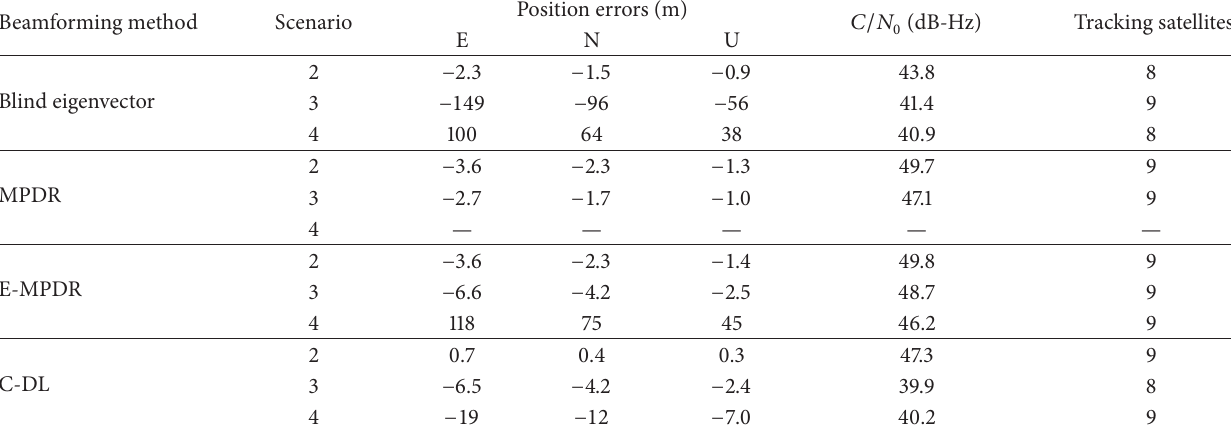
Table 12: GPS position domain results for different methods and interference scenarios (for simulated GPS signals). Beamforming